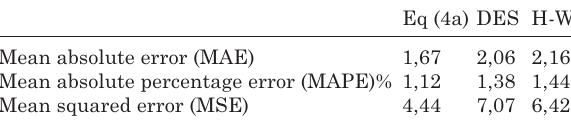
Table 4. Three alternative forecast accuracy